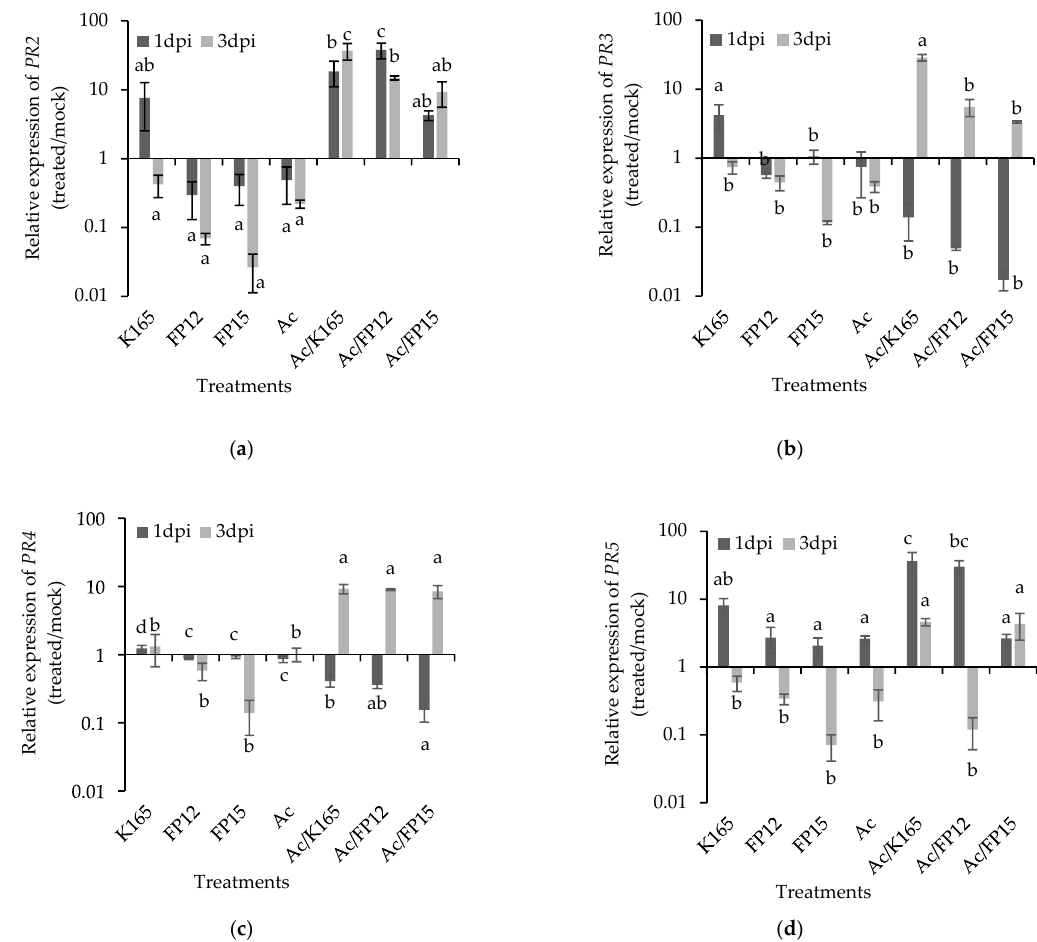
Figure 3. Relative transcript levels of PR2 ( a ), PR3 ( b ), PR4 ( c ) and PR5 ( d ) in the pericarp of grape berries treated with Paenibacillus alvei K165, Blastobotrys sp. strain FP12 or Arthrobacter sp. strain FP15 in response to infection with Aspergillus carbonarius . The samples for RNA isolation were collected at 1 and 3 days post inoculation (dpi) with the pathogen. The expression levels of PR2 , PR3 , PR4 and PR5 were normalized to the expression of EF-1a measured in the same samples and they are presented as transformed values with the log (x + 1) transformation, in comparison with the normalized expression level of the respective gene in mock treatment. The columns show the means of three biological repeats ( n = 3) and the results are presented on a logarithmic scale. The vertical bars indicate the standard errors. At each day, columns with different letters represent statistically different treatments according to the LSD test ( p <